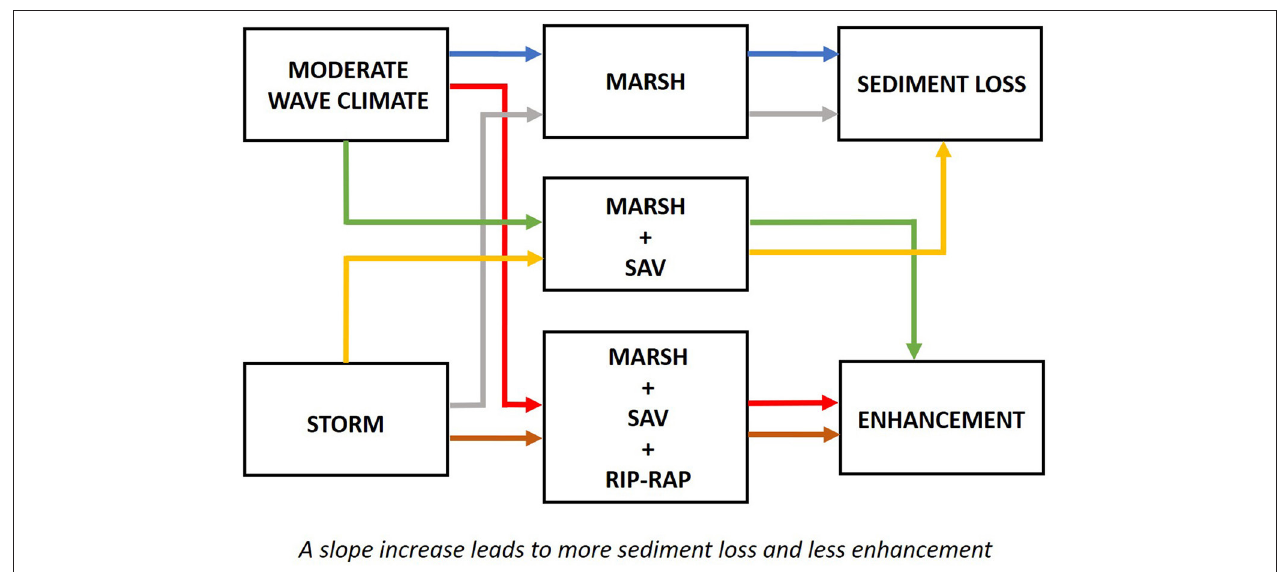
FIGURE 12 | Feedback between wave climates and living shoreline configuration in the sediment